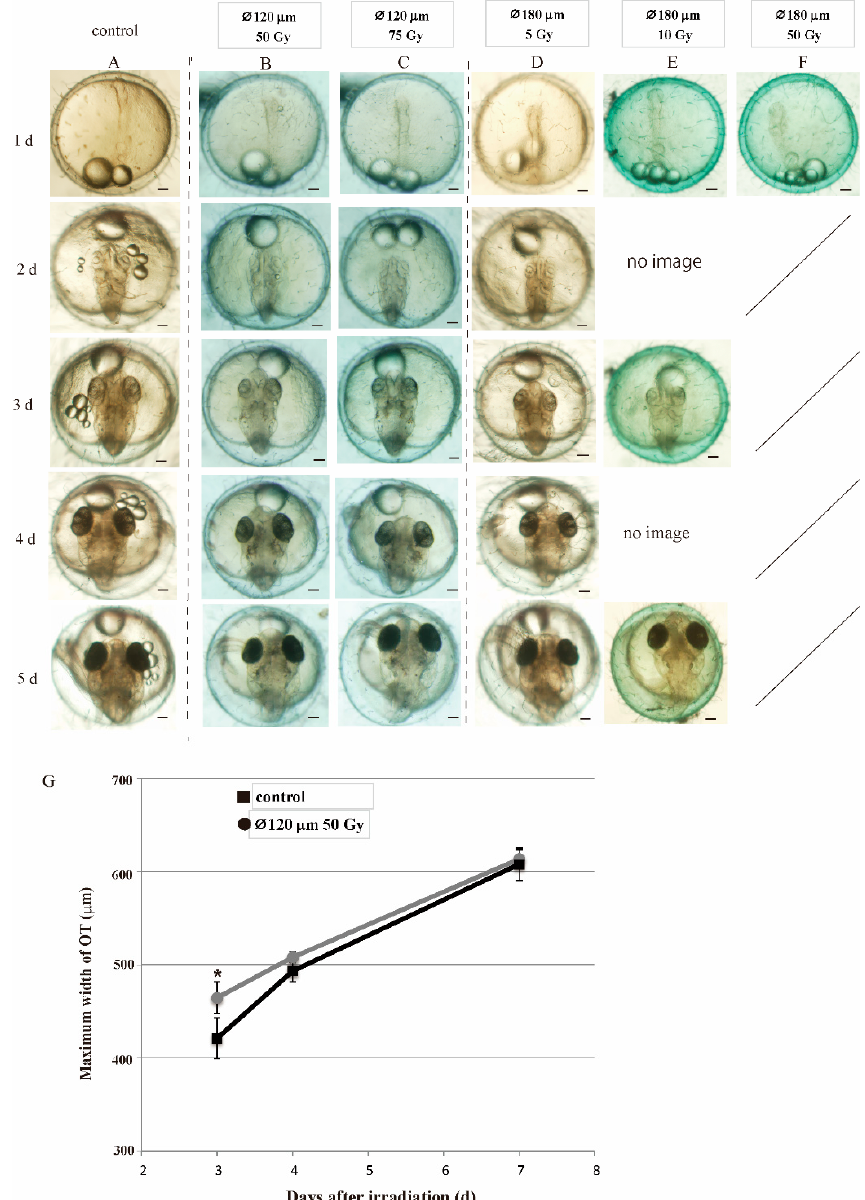
Figure 4. Targeted irradiation of the center of blastoderm with microbeam induced the same developmental disturbance as gamma-rays induced. Blastula embryos were irradiated with a collimated carbon-ions microbeam with diameter of 120 μ m with 50 Gy ( B ) or 75 Gy ( C ), or a microbeam with diameter of 180 μ m with 5 Gy ( D ) and all of the irradiated embryos hatched normally, whereas the embryos irradiated with a microbeam with diameter of 180 μ m with 10 Gy died before hatching ( E ). At 3 days after the irradiation, brains of the blastula embryos irradiated with a microbeam with diameter of 120 μ m with 50 Gy were significantly smaller than the controls ( A , B and G ). Subsequently, the brains of the irradiated embryos developed rapidly and their size became equal to those of the control embryos at 4 days and 7 days after the irradiation. The temporal changes of the maximum width of the OT were shown in G. Scale bars in ( A – F ) = 100 μ m. Error bars show S.D. A p * value < 0.05 was considered statistically significant.